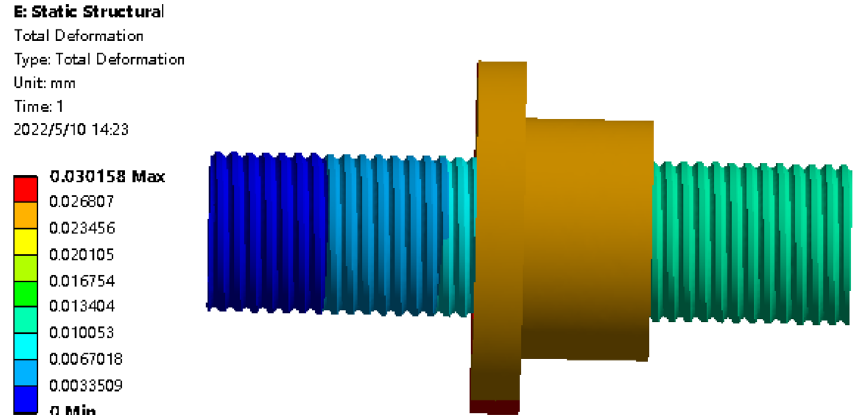
Fig. 11. Cloud diagram of total deformation distribution of ball screw.